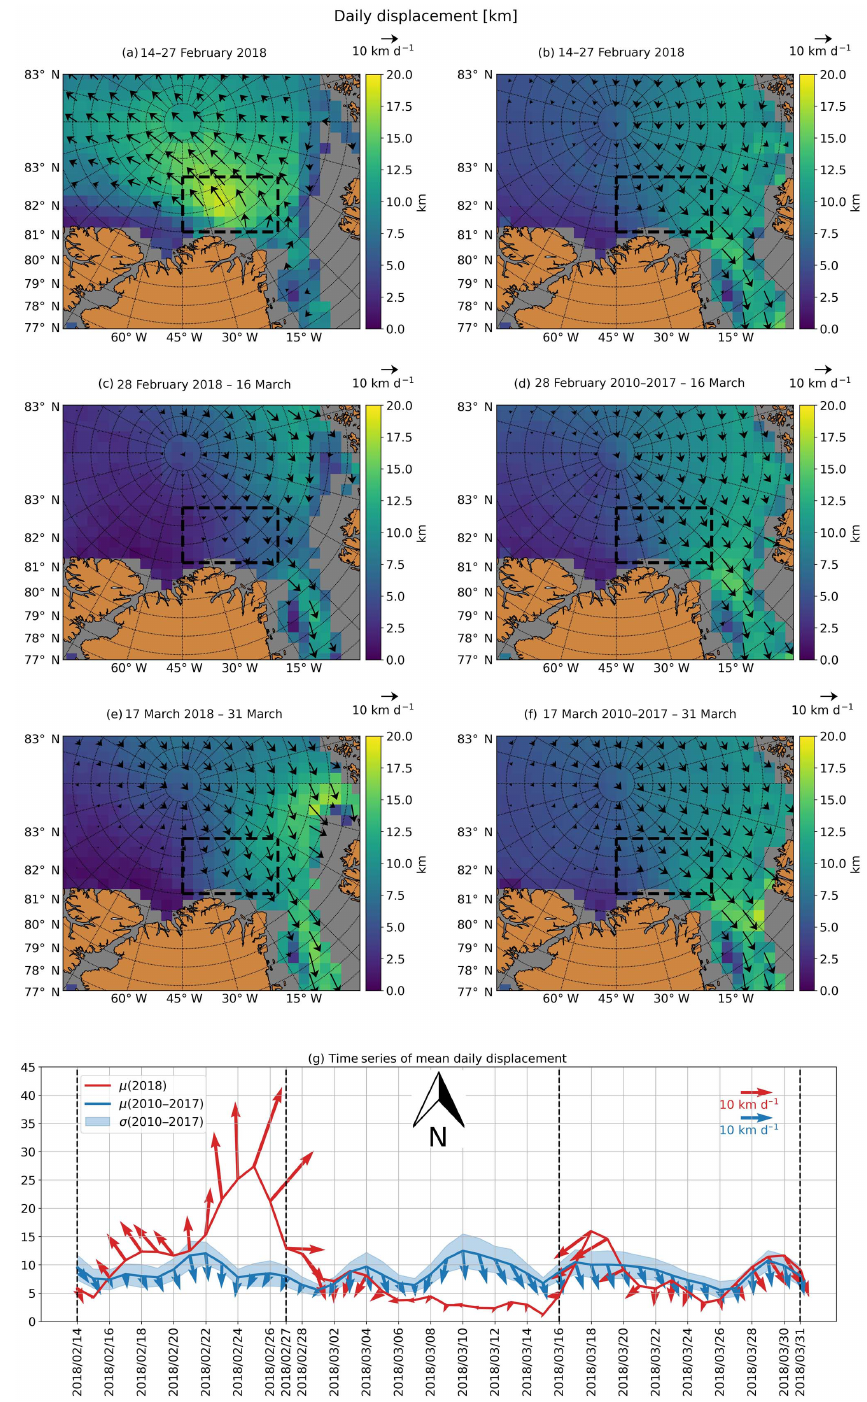
Figure 9. Daily displacement based on the OSI-SAF drift product in the polynya region between 14 February and 31 March. The periods 14–27 February, 28 February–16 March and 17–31 March in 2018 are considered in panels (a) , (c) and (e) . The same periods, but for the mean between 2010 and 2017, are considered in panels (b) , (d) and (f) . The vectors in panels (a) – (f) show the mean sea-ice drift velocity in the corresponding periods, where velocity is defined as displacement per day. Panel (g) shows a time series of the displacement (lines), the standard error of the sea-ice drift between 2010 and 2017, defined as standard deviation divided by the square root of the number of years (blue shades) and the sea-ice drift velocity (vectors). The orientation is such that an upward-pointing vector points towards north. The arrows in the top right give the scale of the arrow length. Displacement and sea-ice drift velocity are the averages in the dashed black boxes in panels (a) – (f)